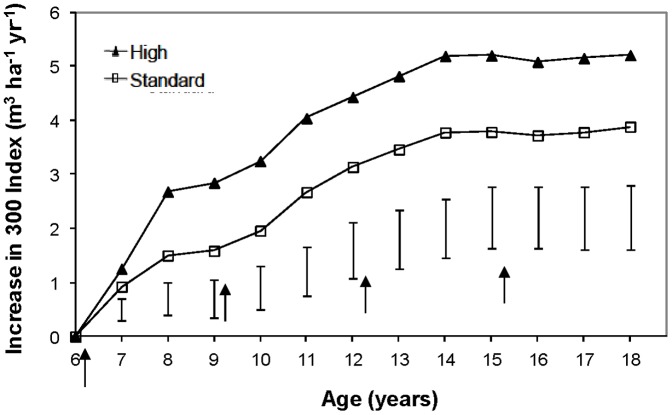
Mean volumes in broad log grade groupings for each biosolids treatment.